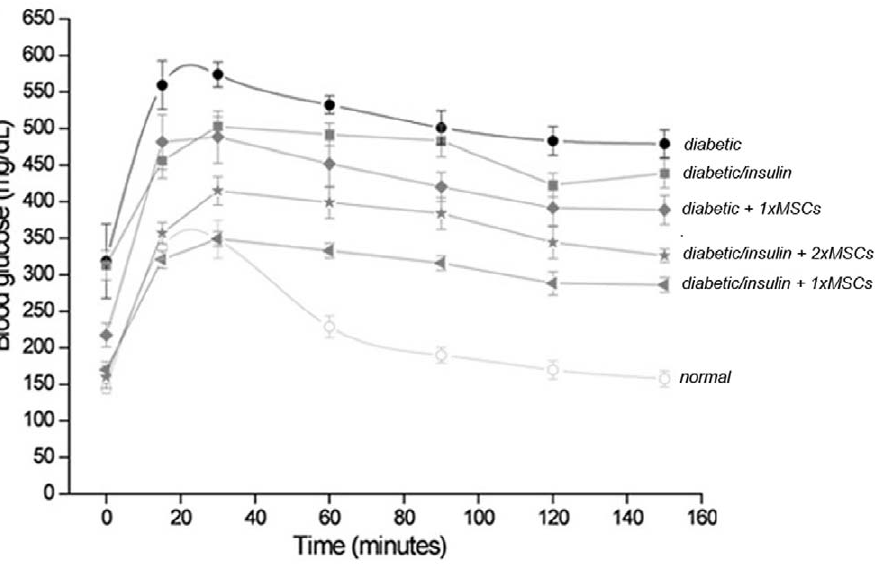
Figure 4. Glucose tolerance improvement in diabetic mice after MSC transplantation. At day 130 after diabetes induction, glucose tolerance was assessed in normal , diabetic , diabetic + 1xMSCs , diabetic/insulin , diabetic/insulin + 1xMSCs and diabetic/insulin + 2xMSCs . Data correspond to mean 6 s.e.m. for 9 animals per experimental group. p , 0.05, diabetic vs. diabetic/insulin + 1xMSC .